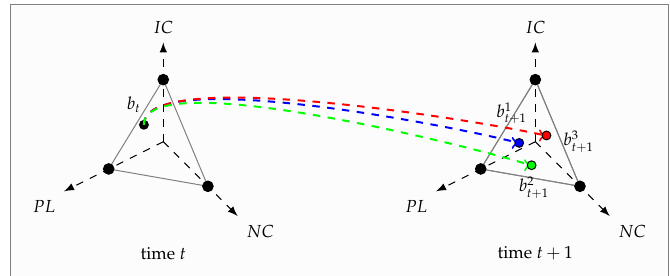
Figure 3. Belief simplex and update of belief